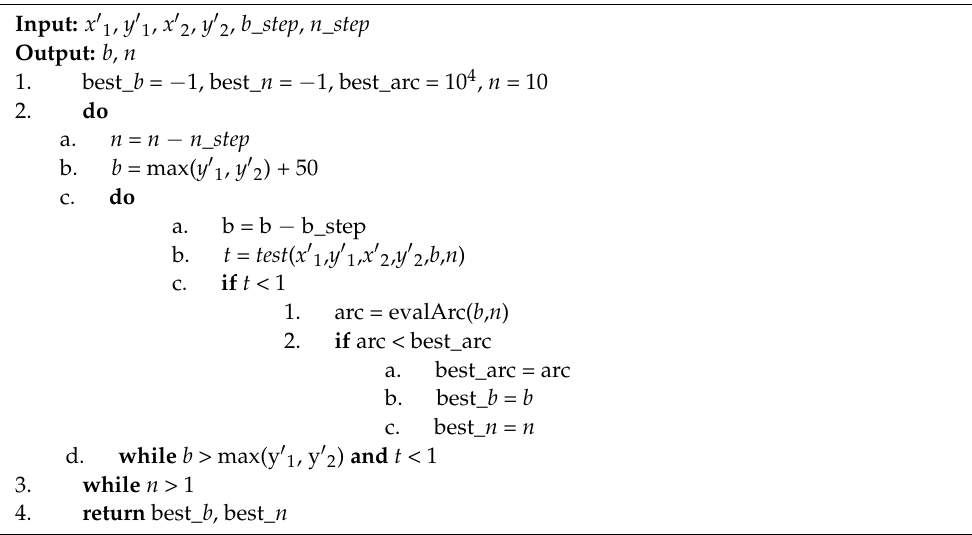
Algorithm 1: Lam é curve parameter